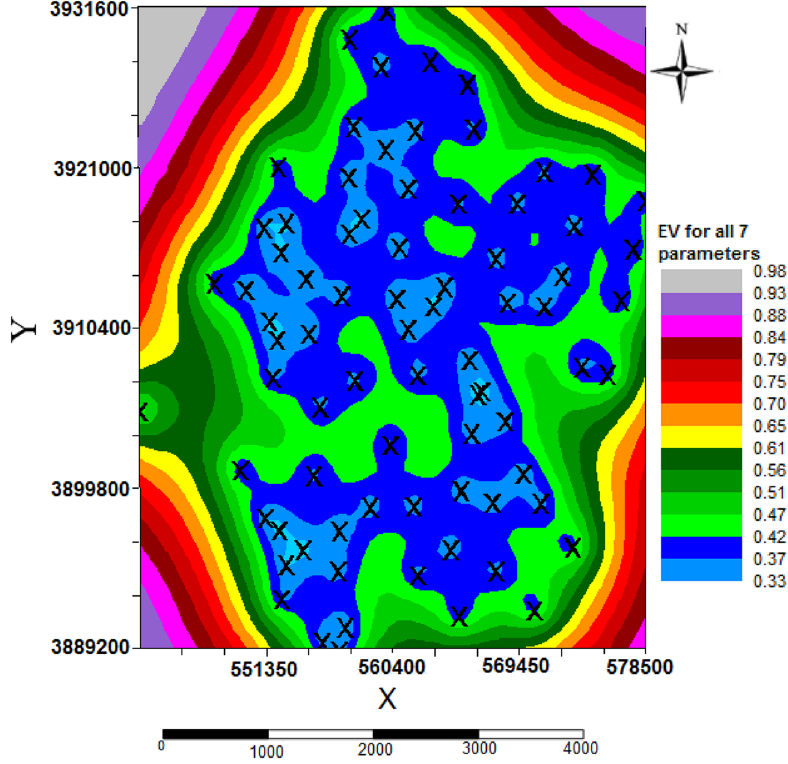
Fig. 6 Map of the estimation variance of the parameters indicating the credibility of the kriging method Fig. 7 Error map of the kriging method highlighting the pro- spective sampling